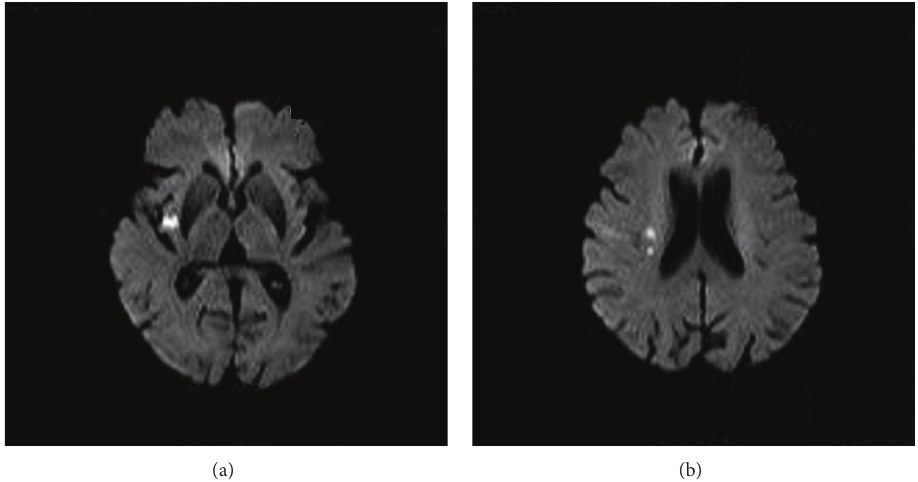
F 2: Magnetic resonance imaging of the brain. High-intensity signal lesions in the right insular cortex (a), and right corona radiata